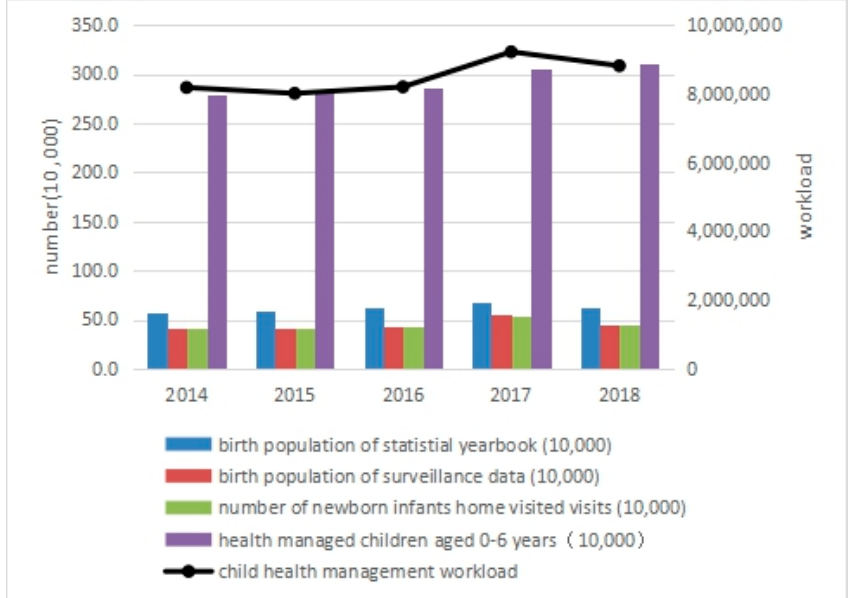
Figure 3. Child health management workload in Zhejiang Province,